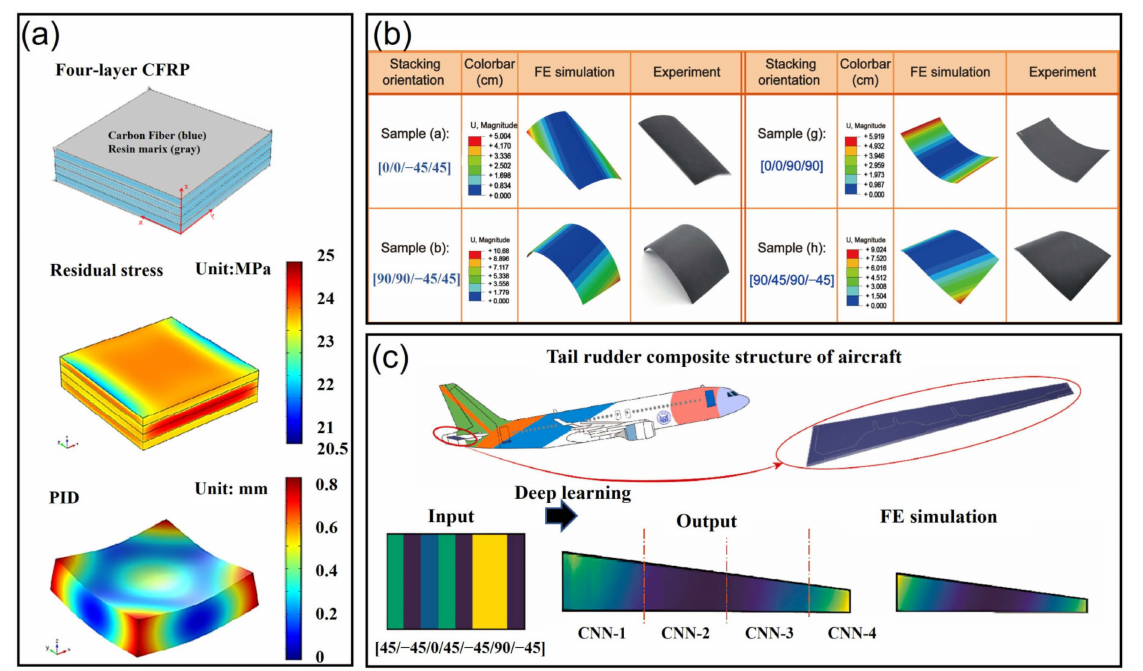
Figure 4. Prediction of PID. ( a ) Residual stress and PID prediction of a four-layer CFRP by FE simulation (Open Access, [58]. 2019, MDPI); ( b ) Laminates with different stacking orientation; and ( c ) Tail rudder composite structure of aircraft by FE simulation and deep learning [59]. 2023,